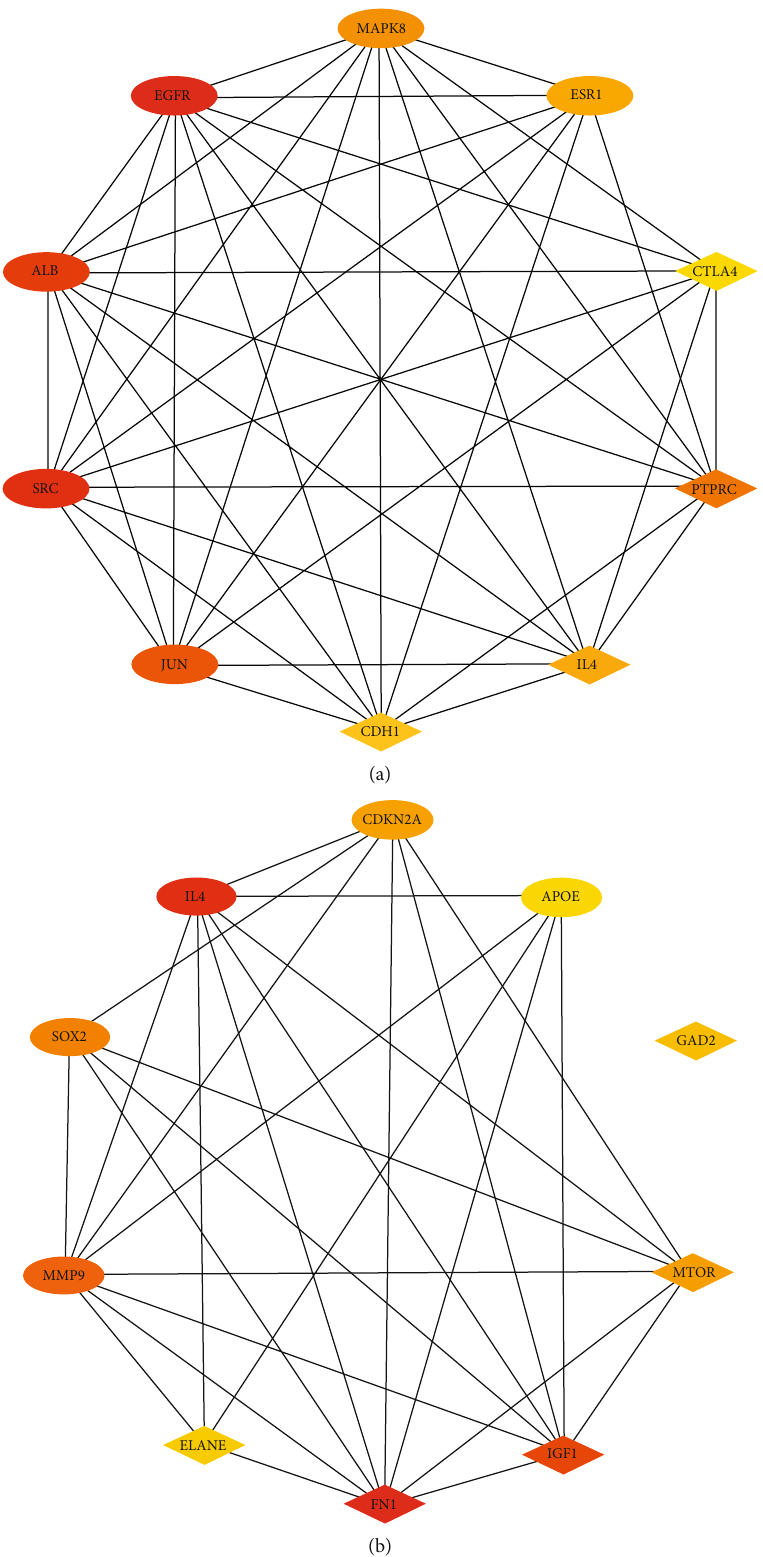
Figure 5: Top 10 genes in degree score from CytoHubba. (a) RA and No-RA groups. (b) M-RA and F-RA groups. The balls represent the upregulated genes, and the diamonds represent the downregulated